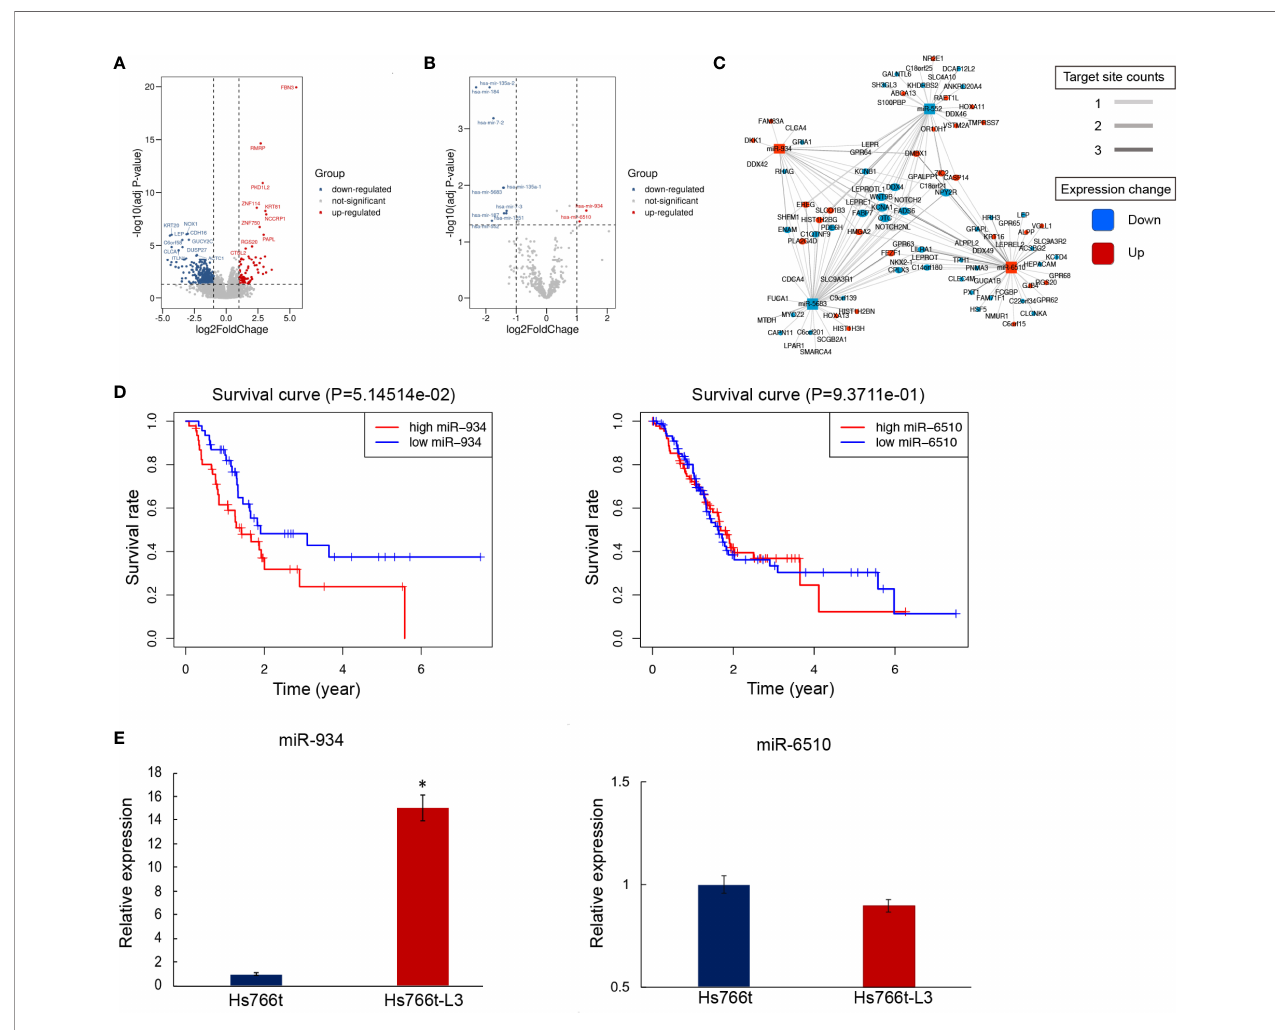
FIGURE 1 | Differential mRNA and miRNA expression in pancreatic adenocarcinomas (PAAD) subjects with/out metastasis. (A, B) Overall pattern of differential mRNA gene (A) and miRNA (B) expression in PAAD with/out metastasis is presented via a volcano plot. (C) Net correlation of mRNA and miRNA. (D) Kaplan-Meier curves showing overall survival (OS) of PAAD patients strati fi ed based on miR-934 expression levels. (E) Relative expression of miR-6510 and miR-934 in Hs766t and Hs766t-L3 cells ( t test, * P <